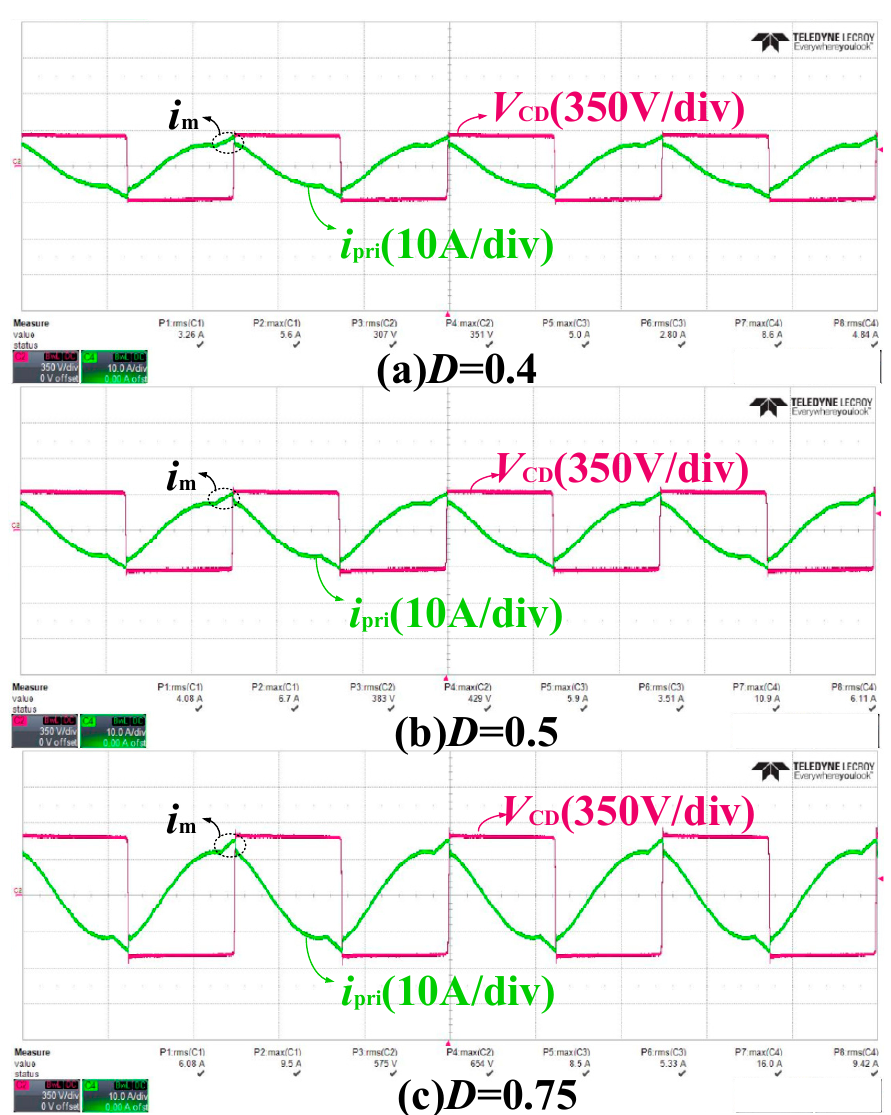
Figure 22. Experimental waveforms of the magnetizing inductor current under different modulation indices D .